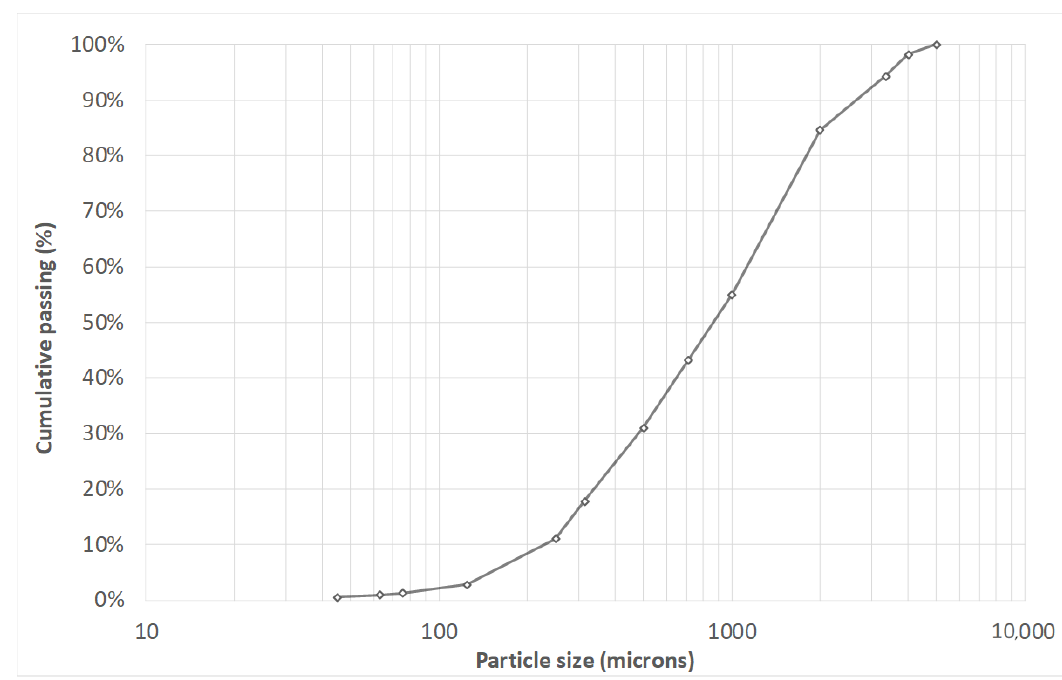
Figure 1. PSD for the Barruecopardo ore head samples. F 80 for the Barruecopardo sample is 1690 µm. Table 2 shows W contents obtained from a mineralogical study for each size interval. Table 2. Fractional results of XRF (ND = not detected).